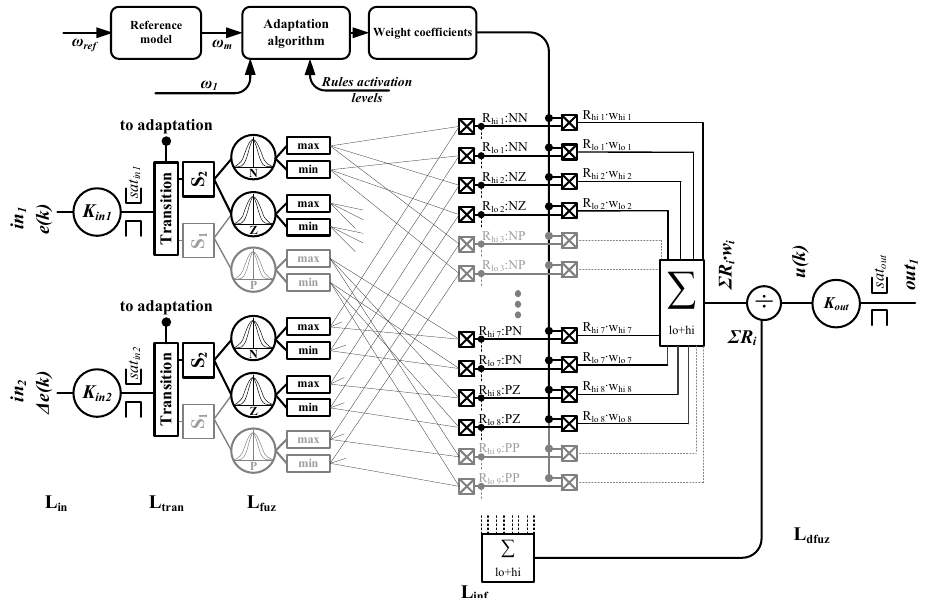
Figure 1. Schematic diagram of the controller with Petri transition layers.